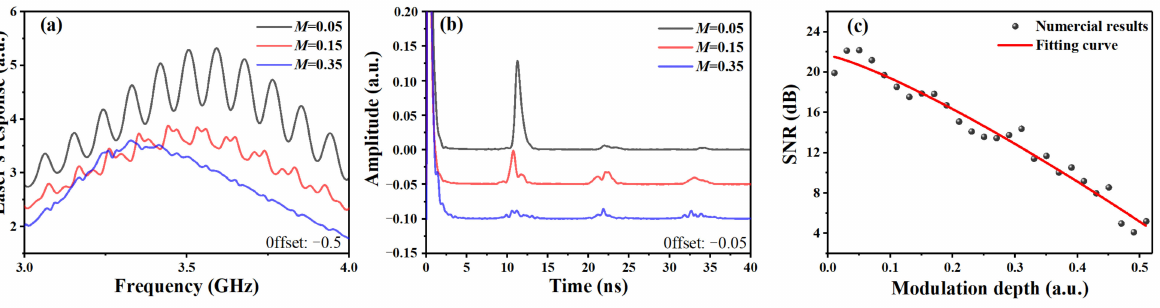
Figure 6. ( a ) Modulation response curve and ( b ) IFT with different modulation depths of 0.05, 0.15, and 0.35; ( c ) SNR versus modulation depth.